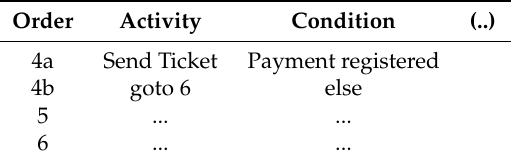
Table 3. Simple example of a XOR-gateway